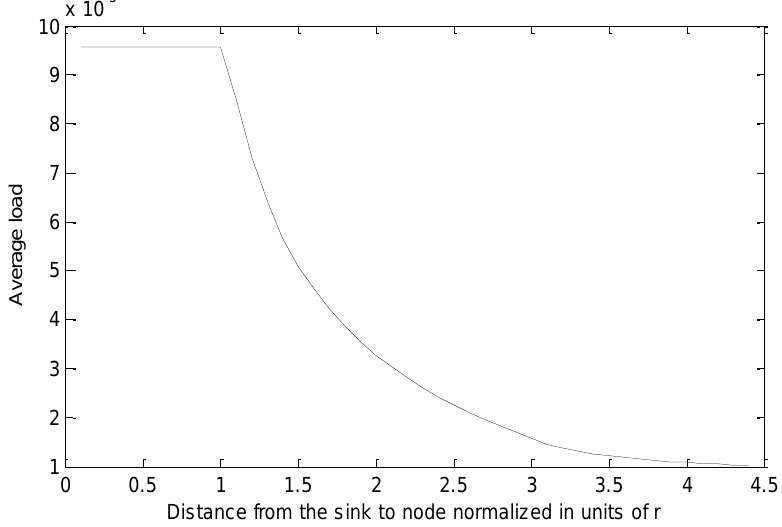
Figure 5. Load distribution in MOL-enabled PMRC-based